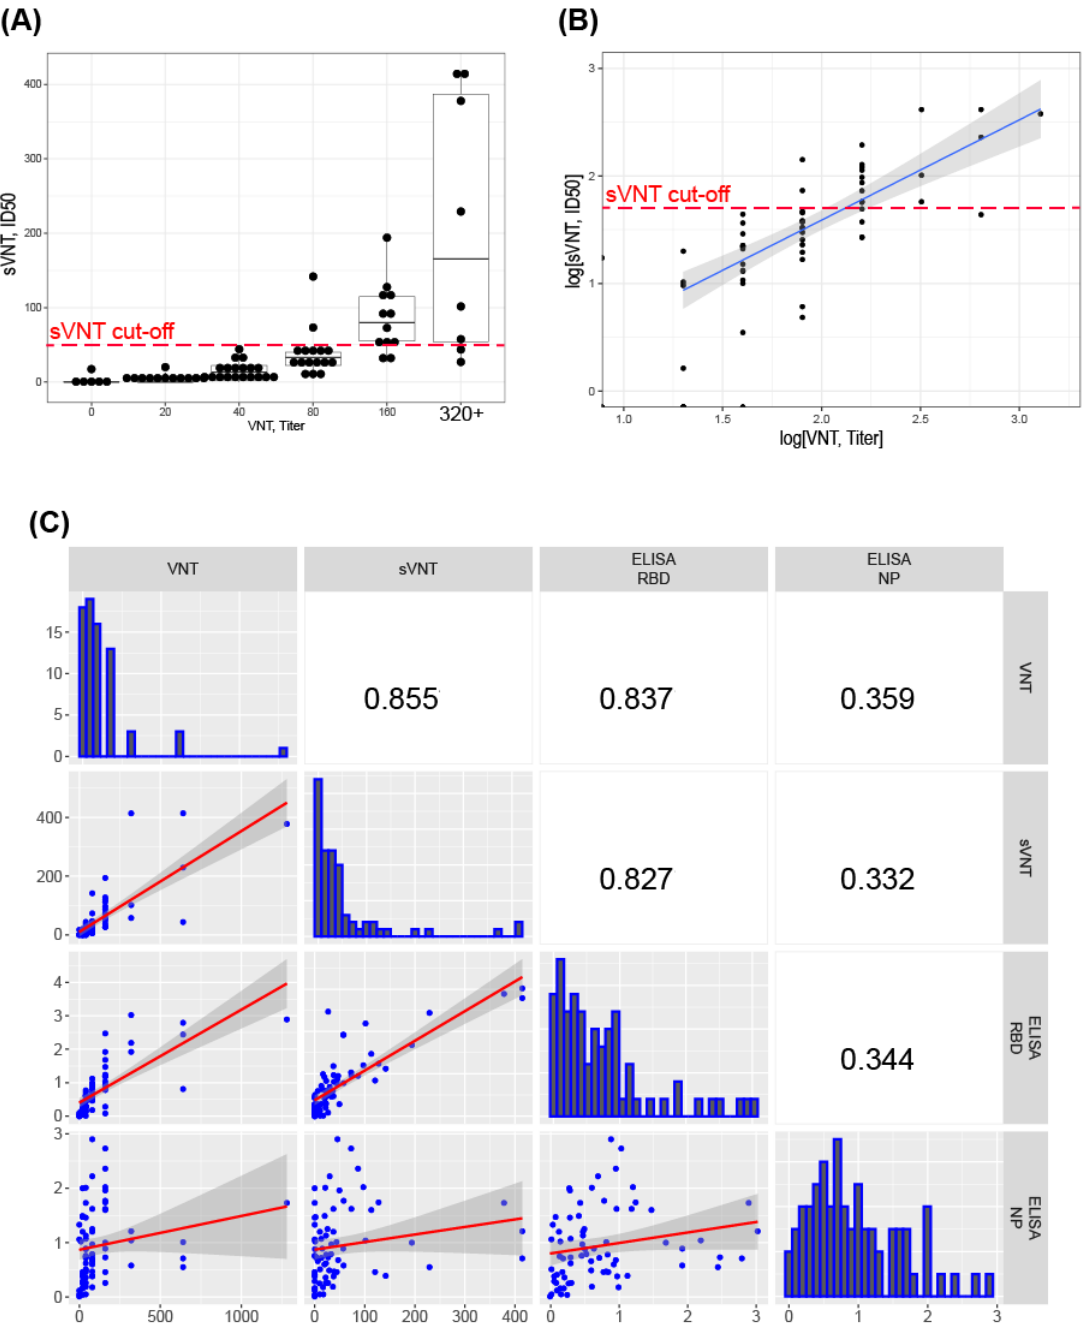
Figure 4. Correlation of the sVNT and VNT data, convalescent plasma samples. ( A ) Comparative analysis of individual serum samples, proposed sVNT cut-off marked with the red dashed line. ( B ) Correlation analysis of the VNT and sVNT levels of nAb, log scales. ( C ) Correlation analysis matrix for 73 COVID-19 sera with different levels of SARS-CoV-2 NAbs measured with VNT, sVNT, indirect RBD ELISA, indirect NP ELISA. Calculated characteristic values for each serum: VNT—serum dilution, corresponding to the 50% plaque reduction; sVNT—dilution, corresponding to 50% inhibition of complex formation (ID 50 ); RBD ELISA and NP ELISA-OD/CO. Spearman correlation coefficients. The dark areas indicate the standard deviations of the linear regression plots. n = 2 for sVNT, RBD ELISA, NP ELISA.